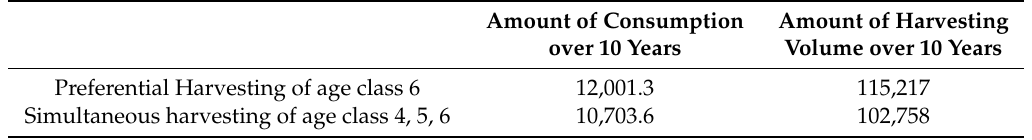
Table 7. Amount of harvesting volume harvesting